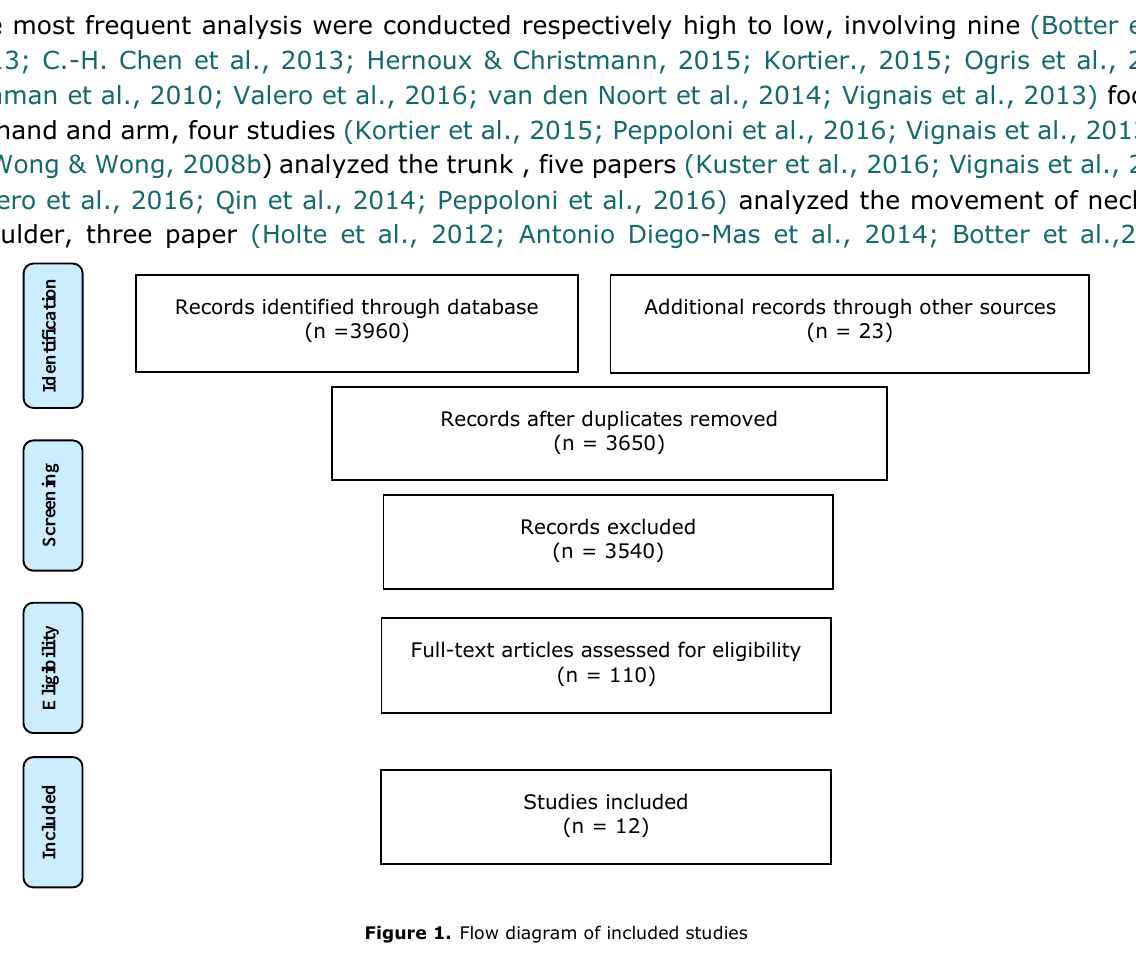
Figure 1. Flow diagram of included studies